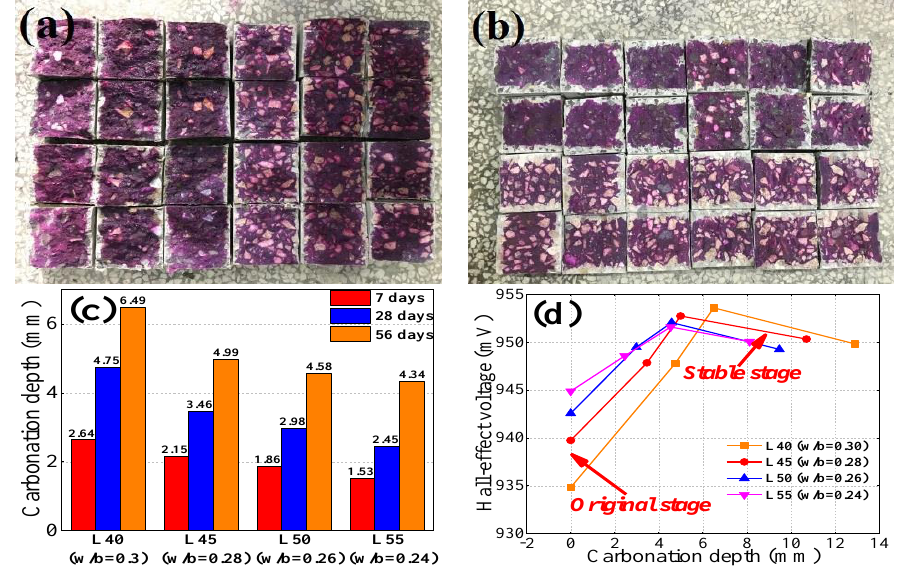
Figure 9. Carbonation test after ( a ) 14 days and ( b ) 56 days of exposure. ( c ) Carbonation depth and ( d ) the relationship between Hall voltage and carbonation depth.